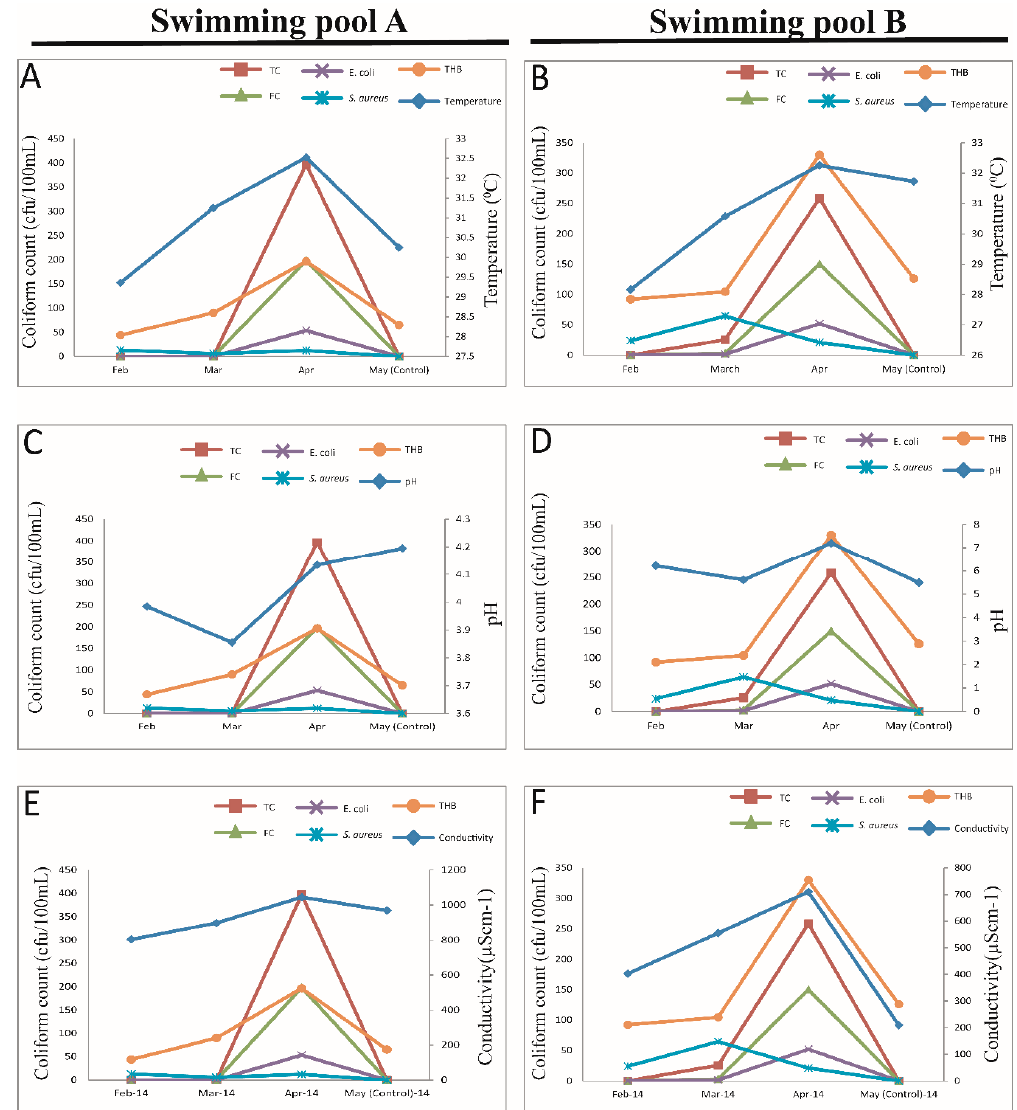
Figure 3. A graph of bacteria counts against temperature ( A and B ), pH ( C and D ), and conductivity ( E and F ) observed in the swimming pools. It should be noted that THB was measured in